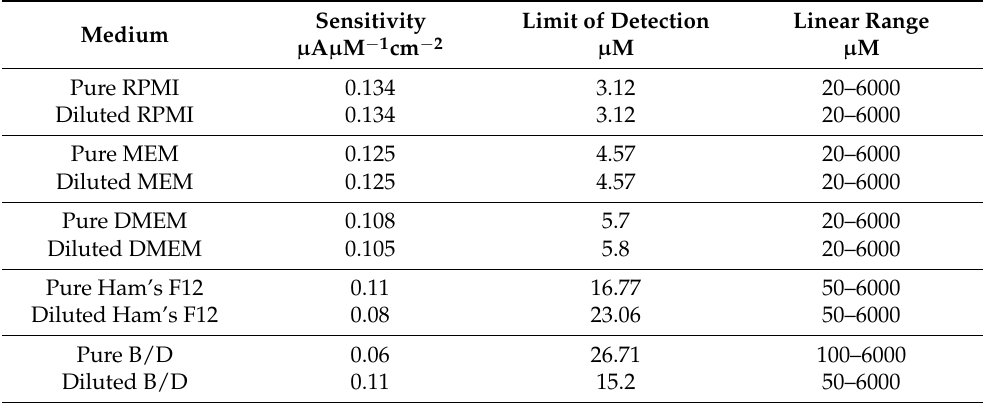
Table 2. Performance of the AuNPs-rGO-based sensors using LSV as the electrochemical technique in different culture media diluted and not diluted with PBS.